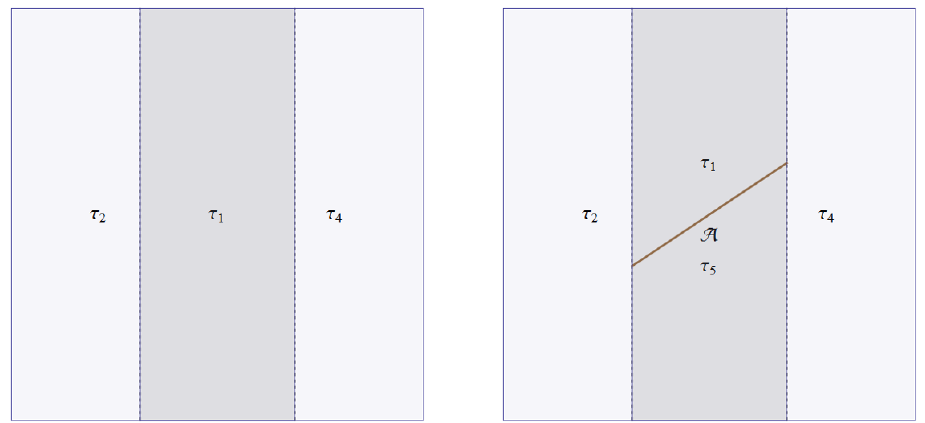
Figure 4 . The causal decomposition for the WCFT, and the assignment of the imaginary parts for each